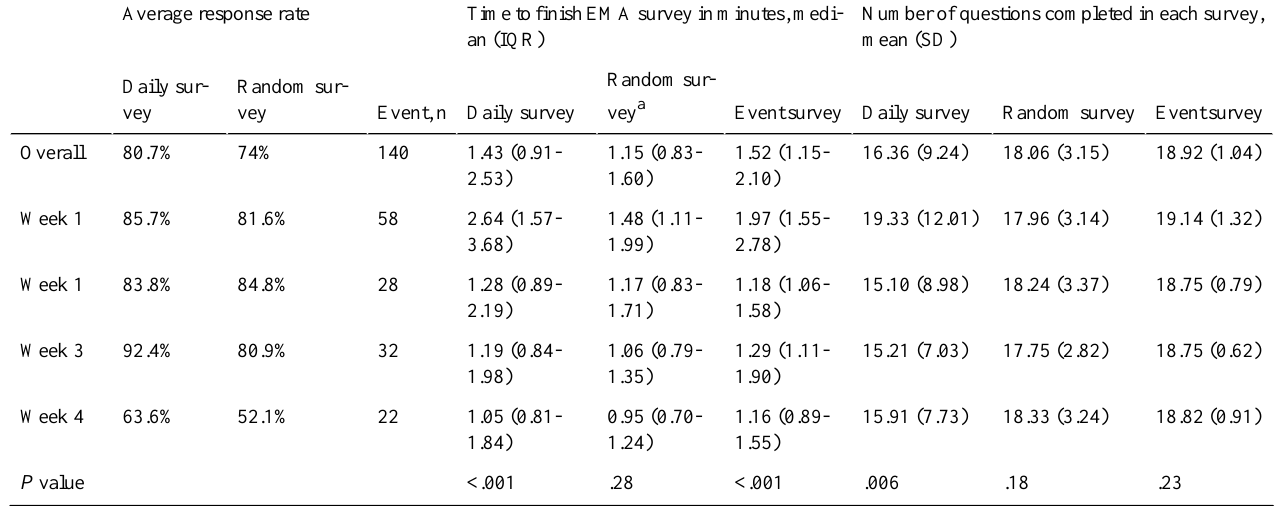
Table 4. Response rates, time to complete EMA survey, and number of questions completed.